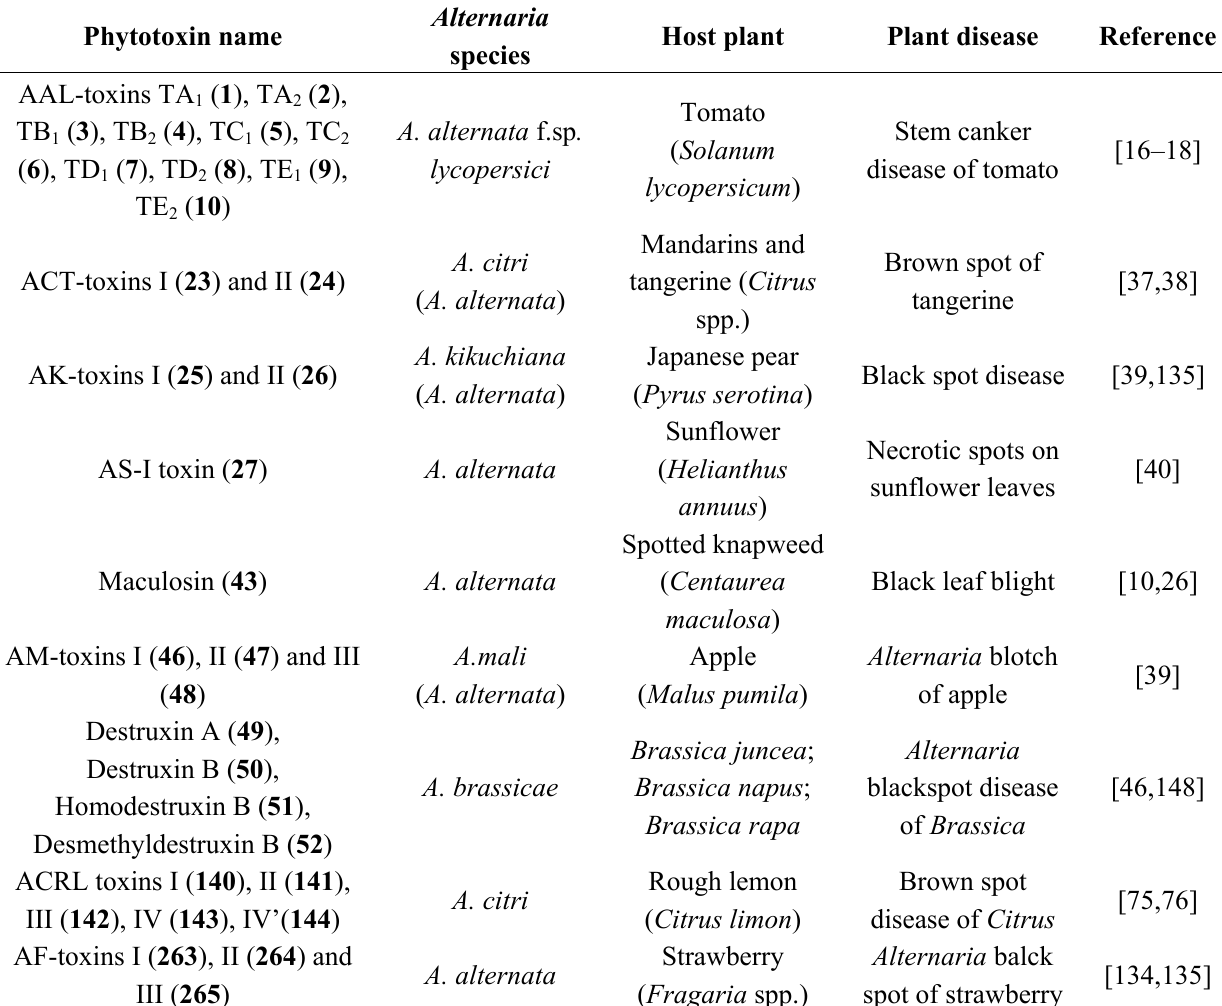
Table 2. Host-specific phytotoxins from Alternaria